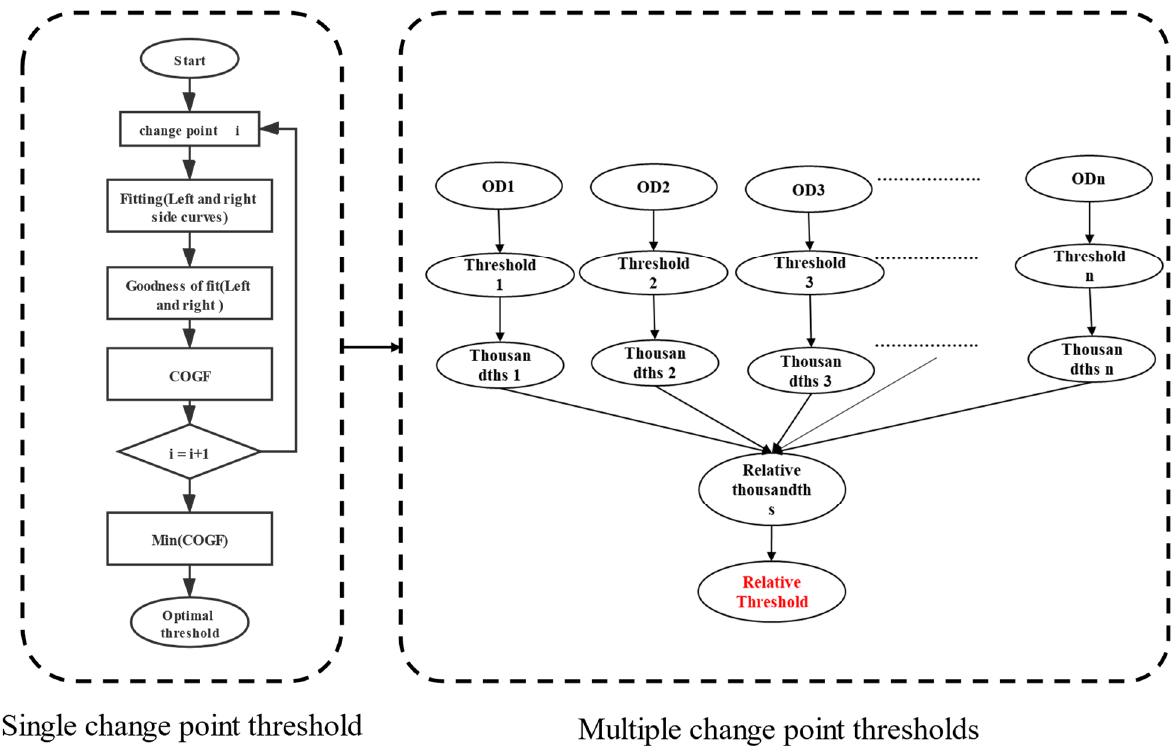
Figure 6. Flow chart of relative threshold derivation.